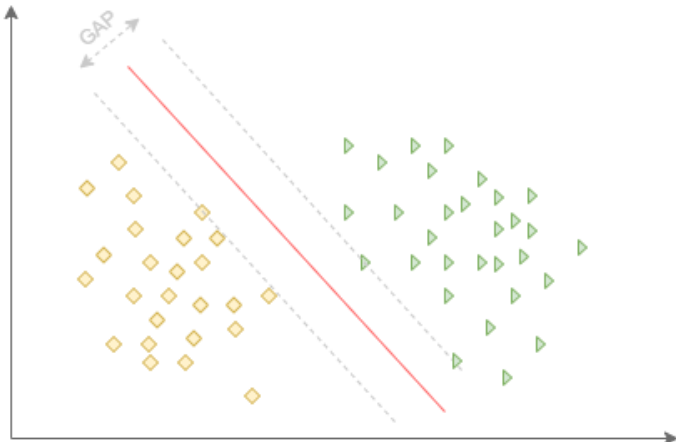
Figure 13. Representation of a support vector machine